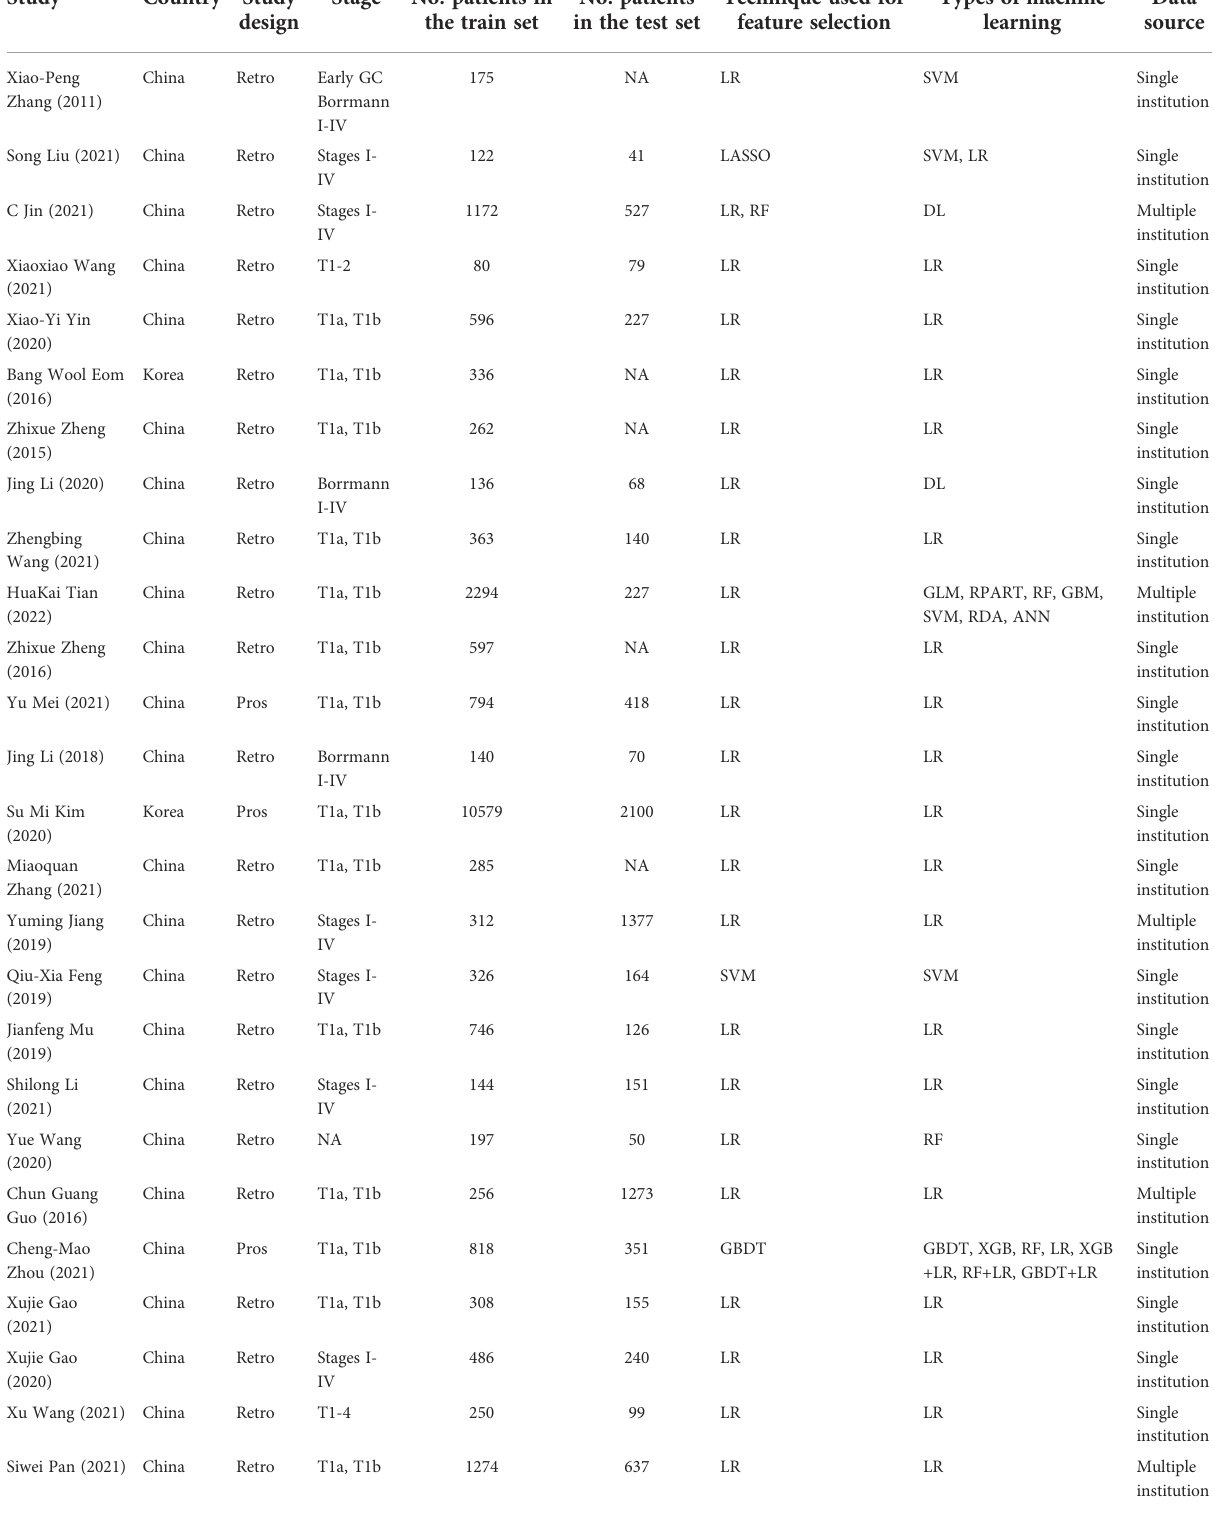
TABLE 1 Characteristics of included